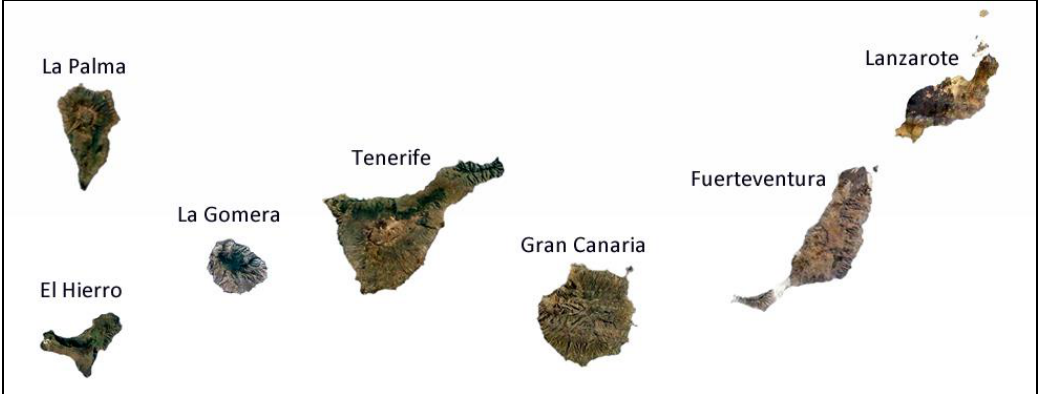
Figure 1. Map of the Canary Islands.